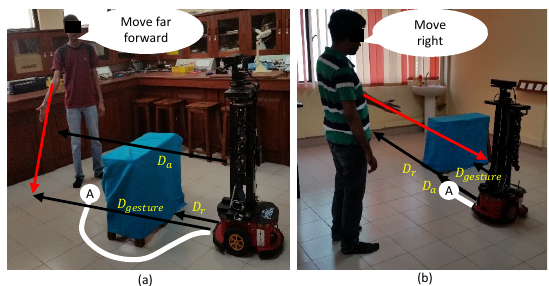
Figure 4. ( a , b ) show two example scenarios that explain the possibility of using pointing gestures in order to identify the intention of the user for switching the perceptive distance. It should be noted that the annotated positions, paths and vectors are not exactly those generated from the system and these are marked for the sake of explanation. Table 1. Rule base of the fuzzy system. S: small; M: medium; L: large; VS: very small and VL: very large. Input